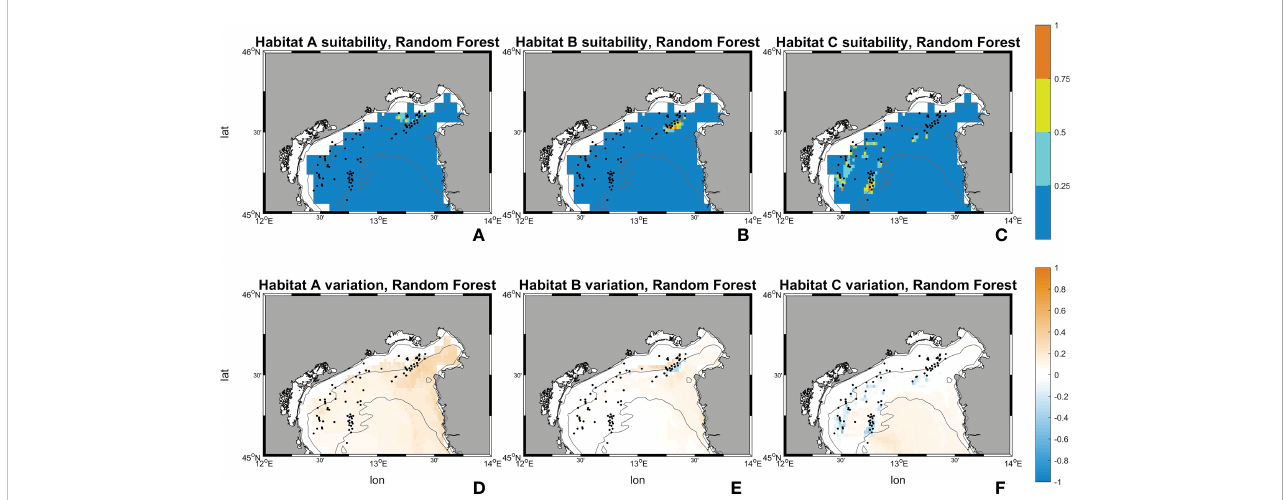
FIGURE 10 Suitability maps (horizontal resolution 0.02°) from Random Forest. Maps (A – C) represents Random Forest suitability for habitat A, B and C during the historical period (1999-2018). Maps (D – F) represents Random Forest future changes according to climate change RCP 8.5 scenario. First line scale legend: 0-0.25 = Low suitability; 0.25-0.5 = Moderate suitability; 0.5-0.75 = High suitability; 0.75-1 = Very high suitability (Thuiller and Münkemüller, 2010; Mousazade et al., 2019). Second line scale legend: -1 = prediction of a suitability decrement in comparison to historical period; 0 = no changes predicted; +1 = prediction of a suitability increment in comparison to historical period.